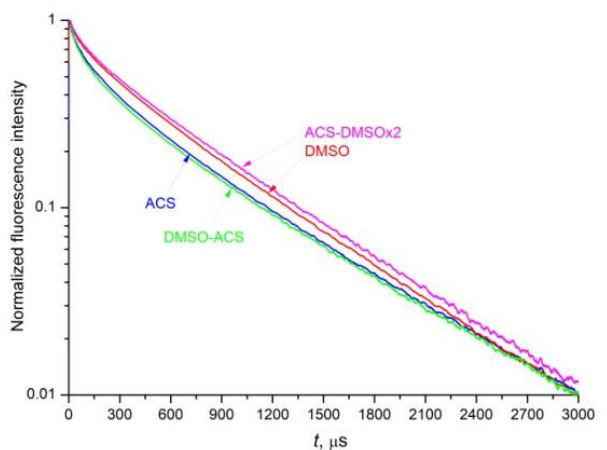
Figure 7. Kinetics of fluorescence decay of the 4 F 3/2 level of the Nd 3+ ion of the 0.1 at.% Nd 3+ : LaF 3 NPs under laser excitation at a wavelength of 789 nm and detection of fluorescence at a wavelength of 863 nm — in aqueous colloidal solutions: ACS and DMSO-ACS colloids (blue and green curves, respectively); and in organic DMSO solvent colloidal solutions: DMSO and ACS-DMSOx2 colloids (red and magenta curves, respectively).